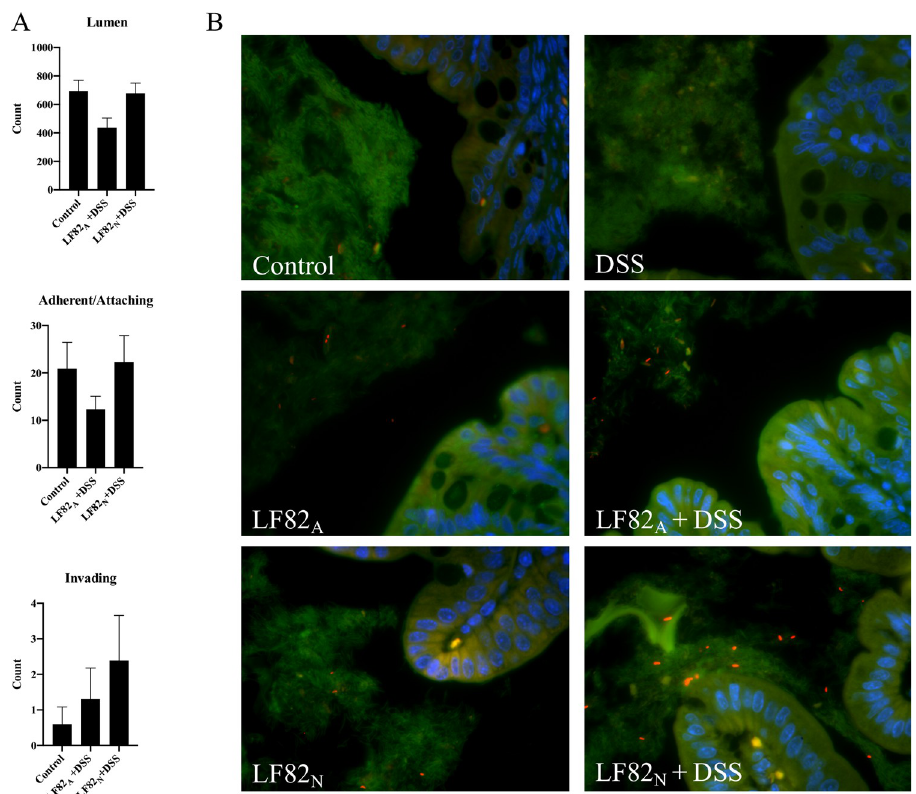
Fig 4. Evaluation of spatial distribution of the microbial community following E . coli LF82 colonization and DSS- induced inflammation. Proximal colons with intact contents were assessed for overall microbial spatial distribution by fluorescent in situ hybridization (FISH). Spatial distribution of organisms was evaluated using a eubacteria probe (EUB338) to detect bacteria in the lumen, adherent/attaching mucus layer, and translocation into the glands ( A ). Representative photomicrographs (60X magnification) of E . coli LF82 detected in the microbial community by FISH by labeling the nuclei of mucosal cells with DAPI (blue), total bacteria with a EUB338 probe (FITC, green), and labeling with a E . coli -specific probe (Cy-3, orange) ( B ). Control n = 5, LF82 A + DSS n = 8, LF82 N + DSS n = 8.